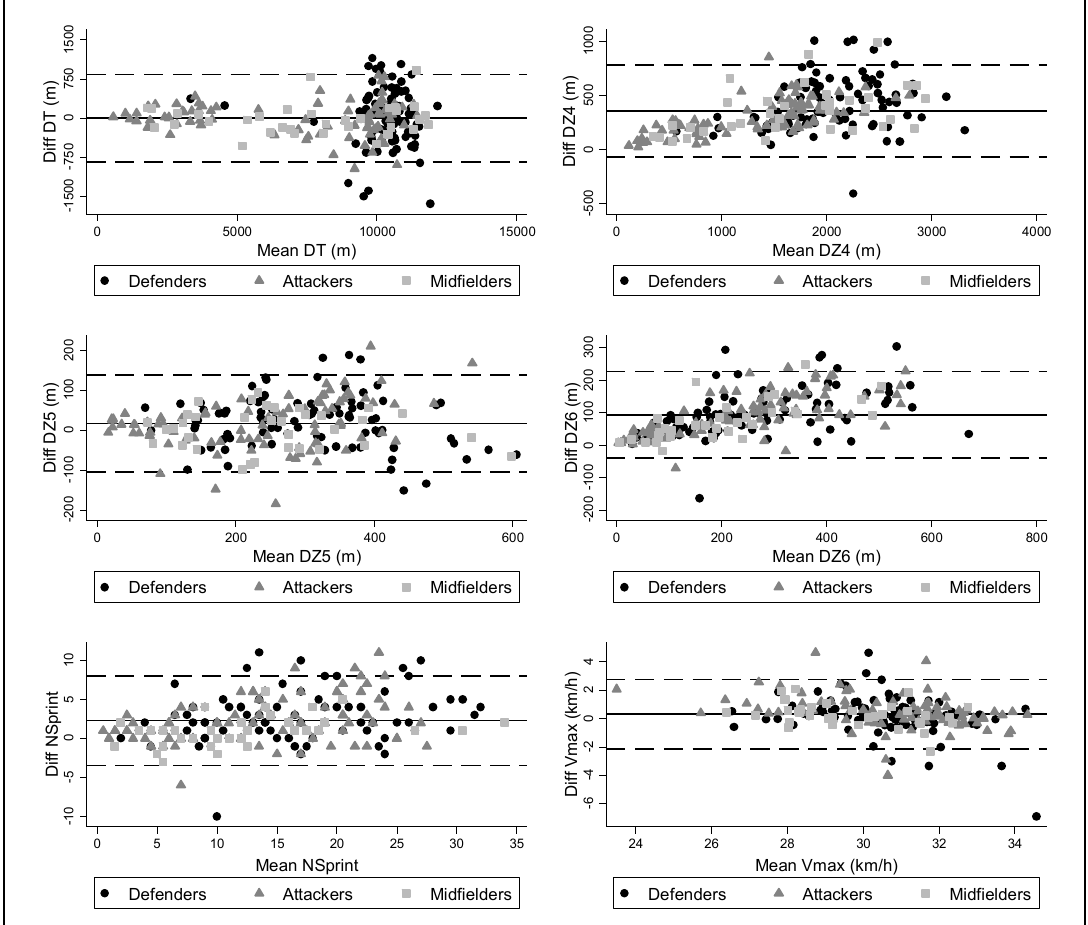
Figure 2. Bland–Altman plots identifying differences when comparing measurements with the Global Positioning System (GPS) devices and the video-based performance analysis system (Mediacoach ® ). Central line represents the inter-methods difference. Upper and lower lines represent the 95% limits of agreement (mean differences ± 1.96 SD of the differences).